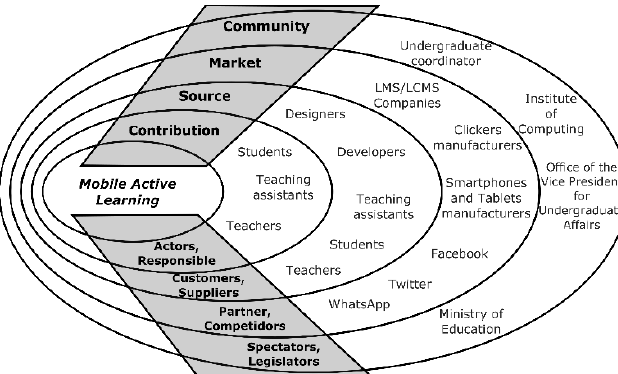
Fig 1. Stakeholder Diagram instantiated